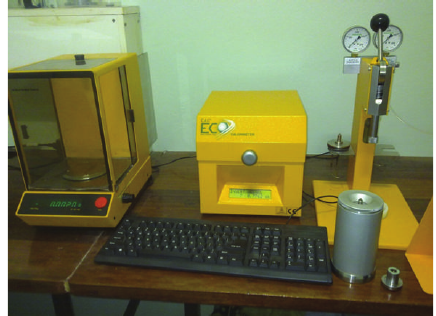
Figure 1: An oxygen bomb